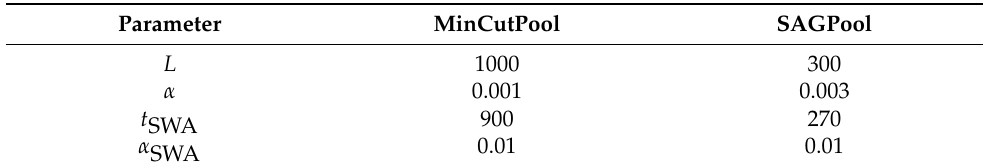
Table A2. The parameter settings for the graph-classification task on dataset NCI1. The baseline optimizer was Adam with weight-decay factor of 0.0005. The variable L denotes the total number of epochs, α is the learning rate of the Adam optimizer, α SWA is the constant learning rate used by SWA, and t SWA is the starting point to launch SWA.